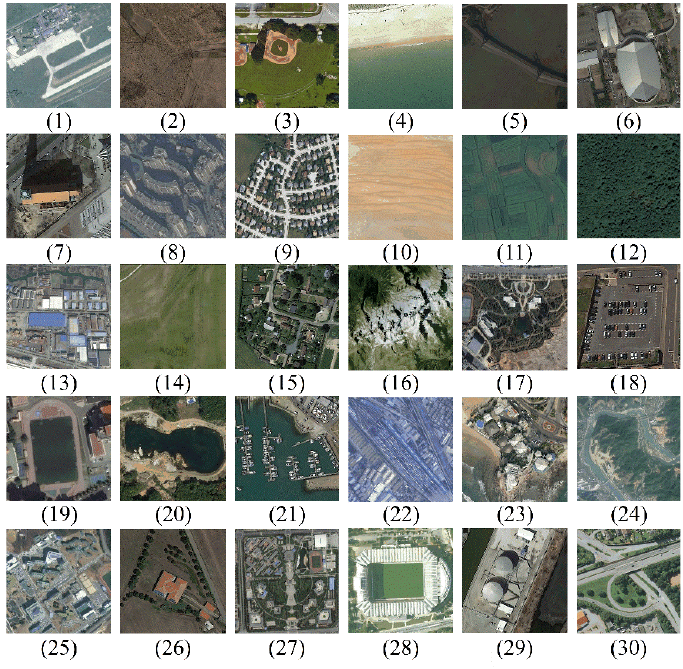
Figure 6. Example images of AID dataset.